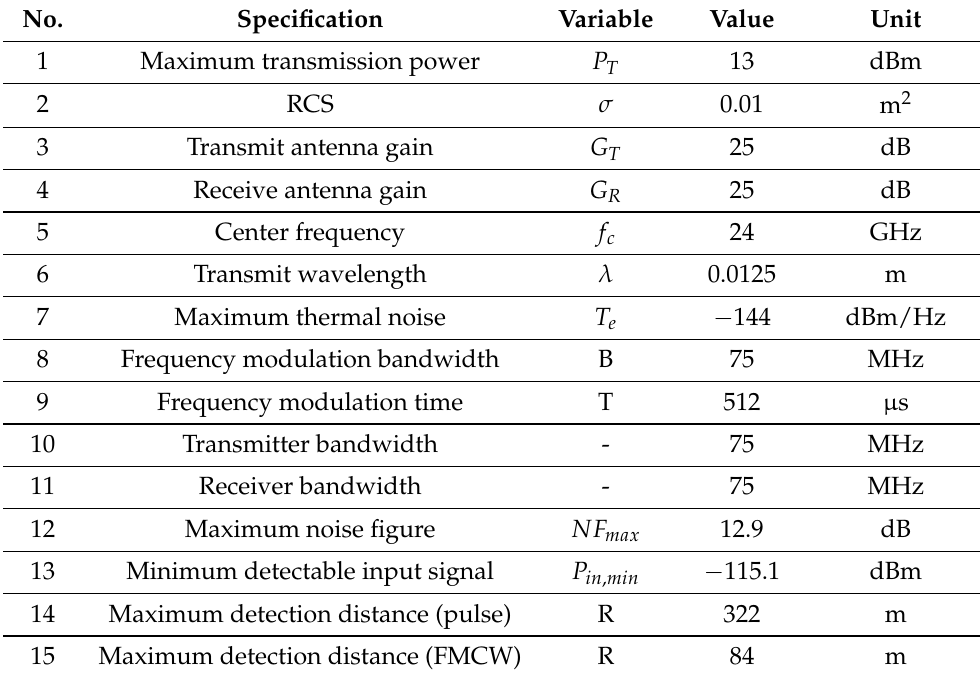
Table 2. Radar transceiver design